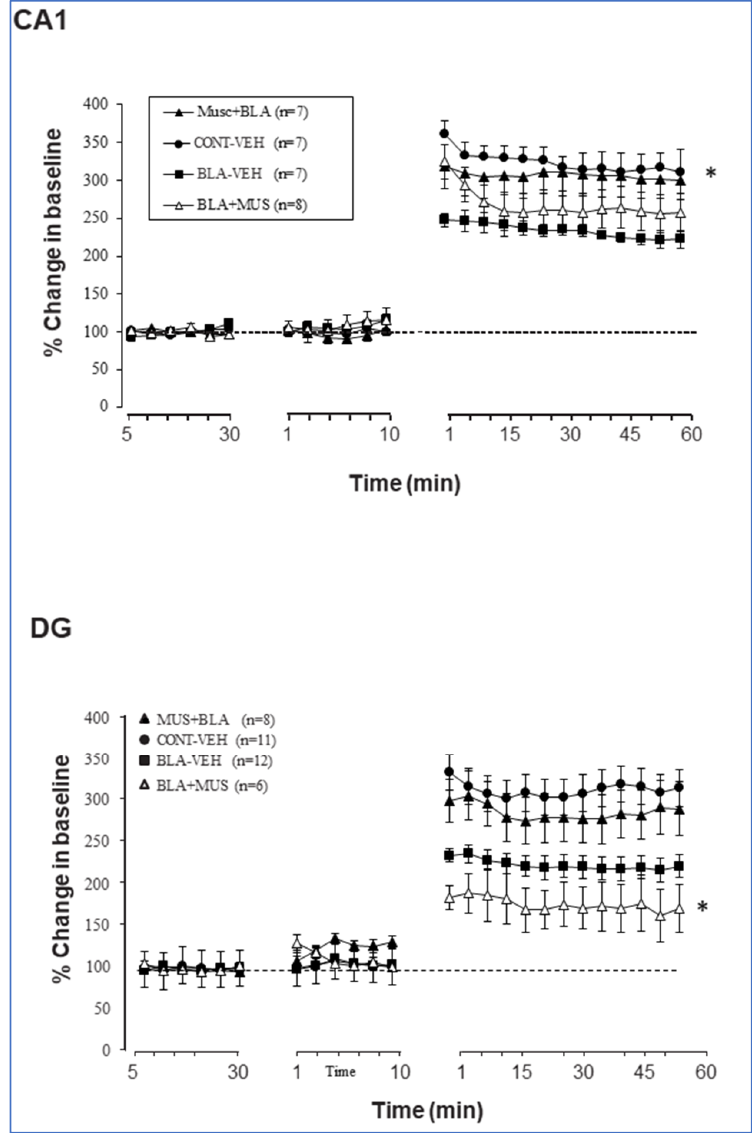
Figure 3. Effects of BLA priming with or without intra-BLA muscimol intervention on LTP induction in the CA1 ( top ) and the DG ( bottom ). In CA1, muscimol prior to BLA priming reduced the inhibitory effect of BLA priming (MUS-BLA significantly different from BLA-VEH, * p < 0.05). In the DG, muscimol prior to BLA priming had no effect but muscimol after BLA priming prevented the LTP- group (* p <